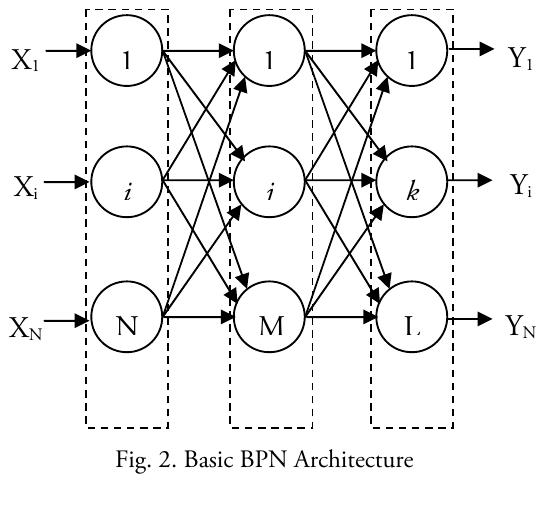
Fig. 2. Basic BPN